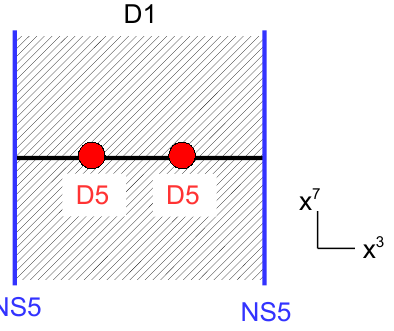
Figure 11 . A D1 brane stretched between the two NS5s, crossing the D3